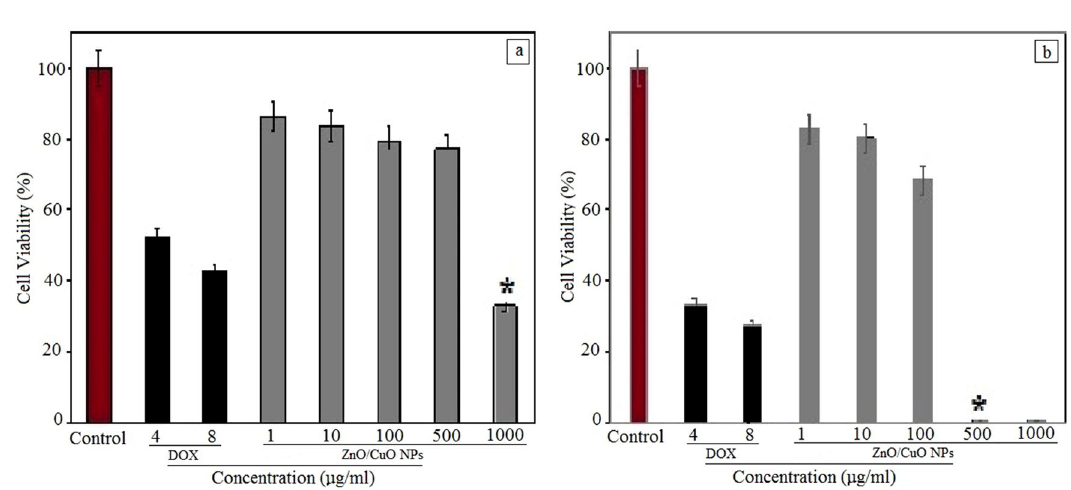
Figure 4. The cell viability (in %) of ( a ) A549 cell line (Human lung cancer cells) and ( b ) A375 cell line (human melanoma cancer cells) in the presence of various concentrations of ZnO/CuO NPs, doxorubicin (positive control) and untreated cells (negative control). * P <